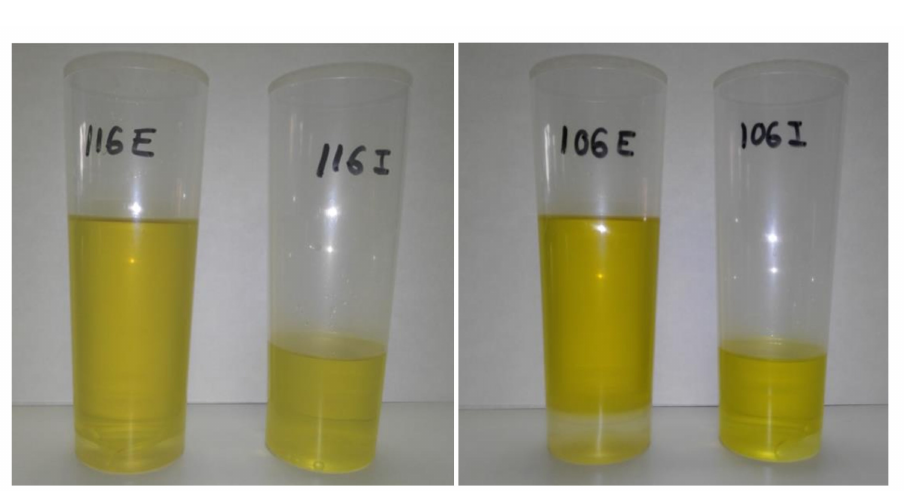
Figure 5. Outer (E) and inner (I) samples obtained in two